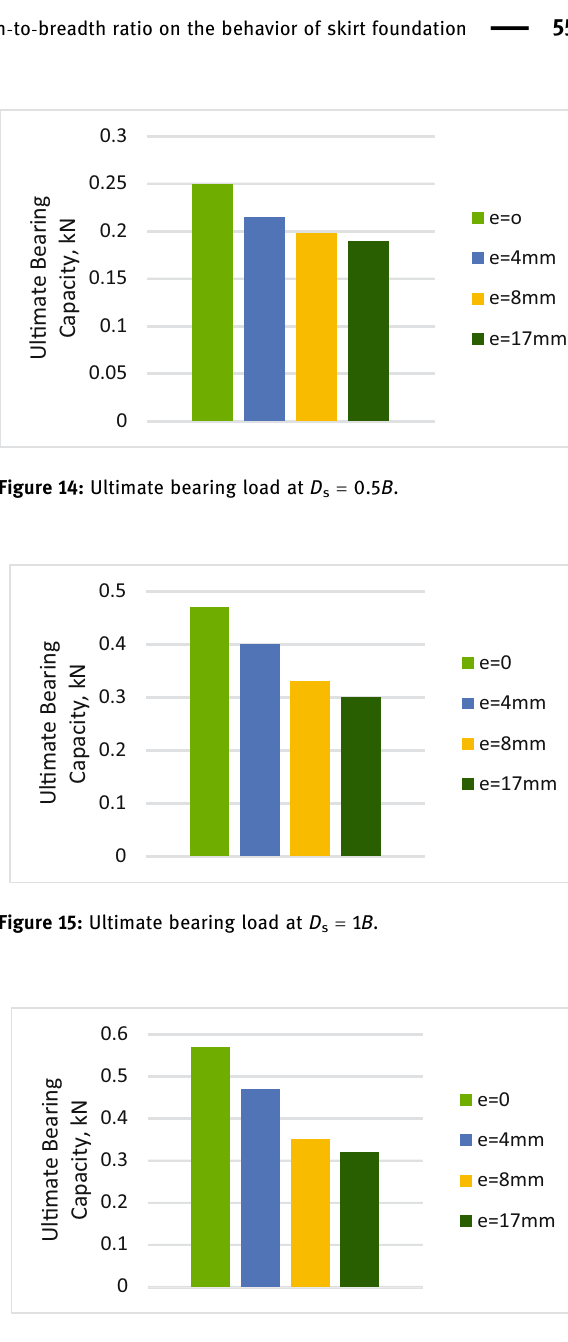
Figure 16: Ultimate bearing load at D s = 1.5 B